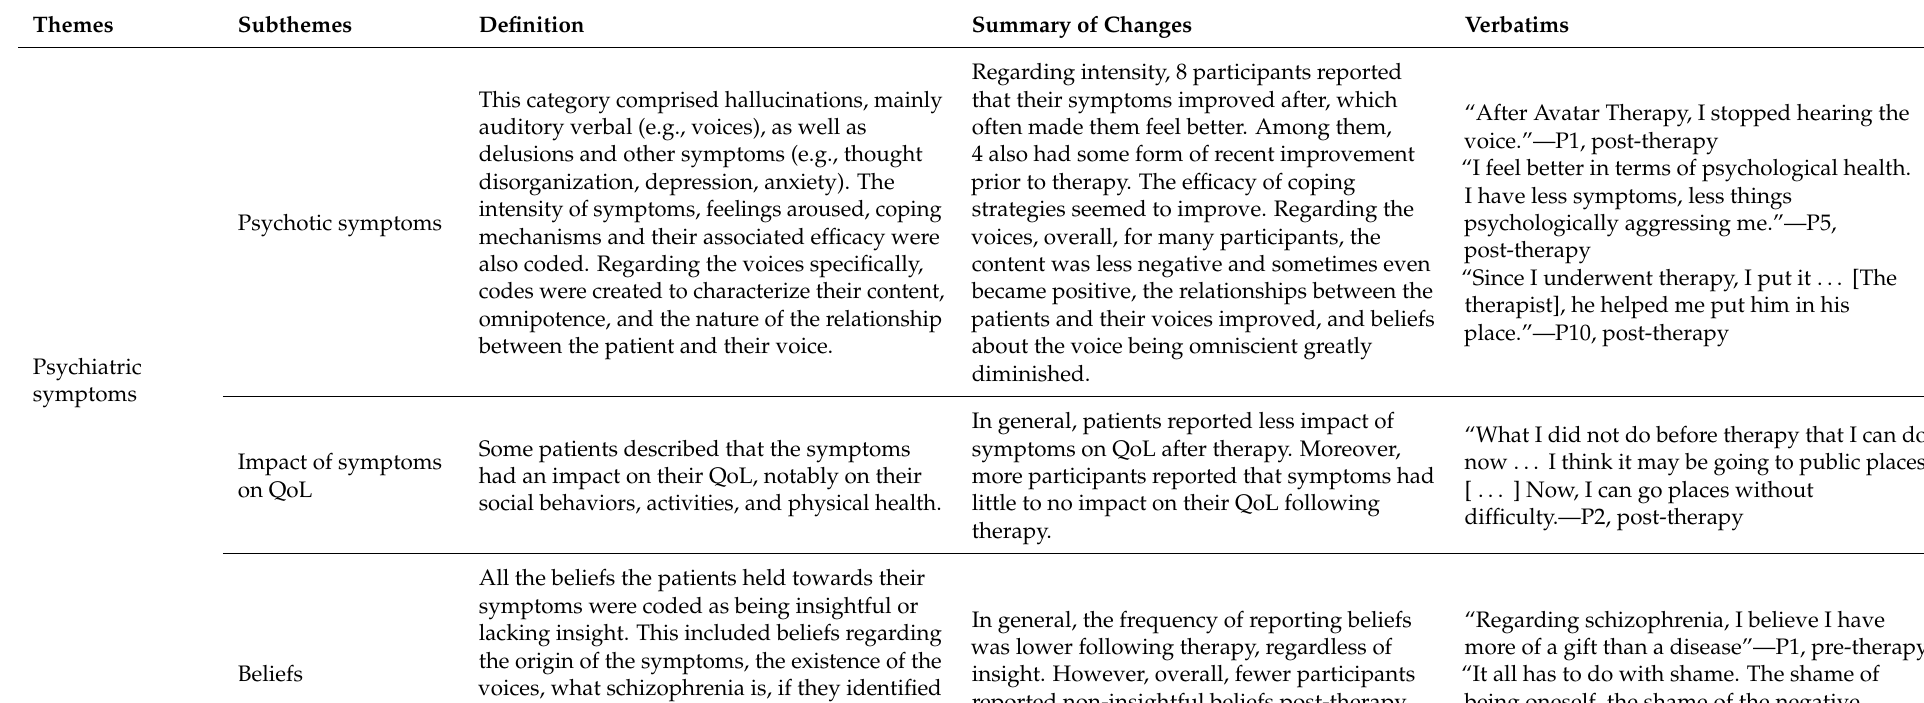
Table 3. Qualitative summary of changes by theme and